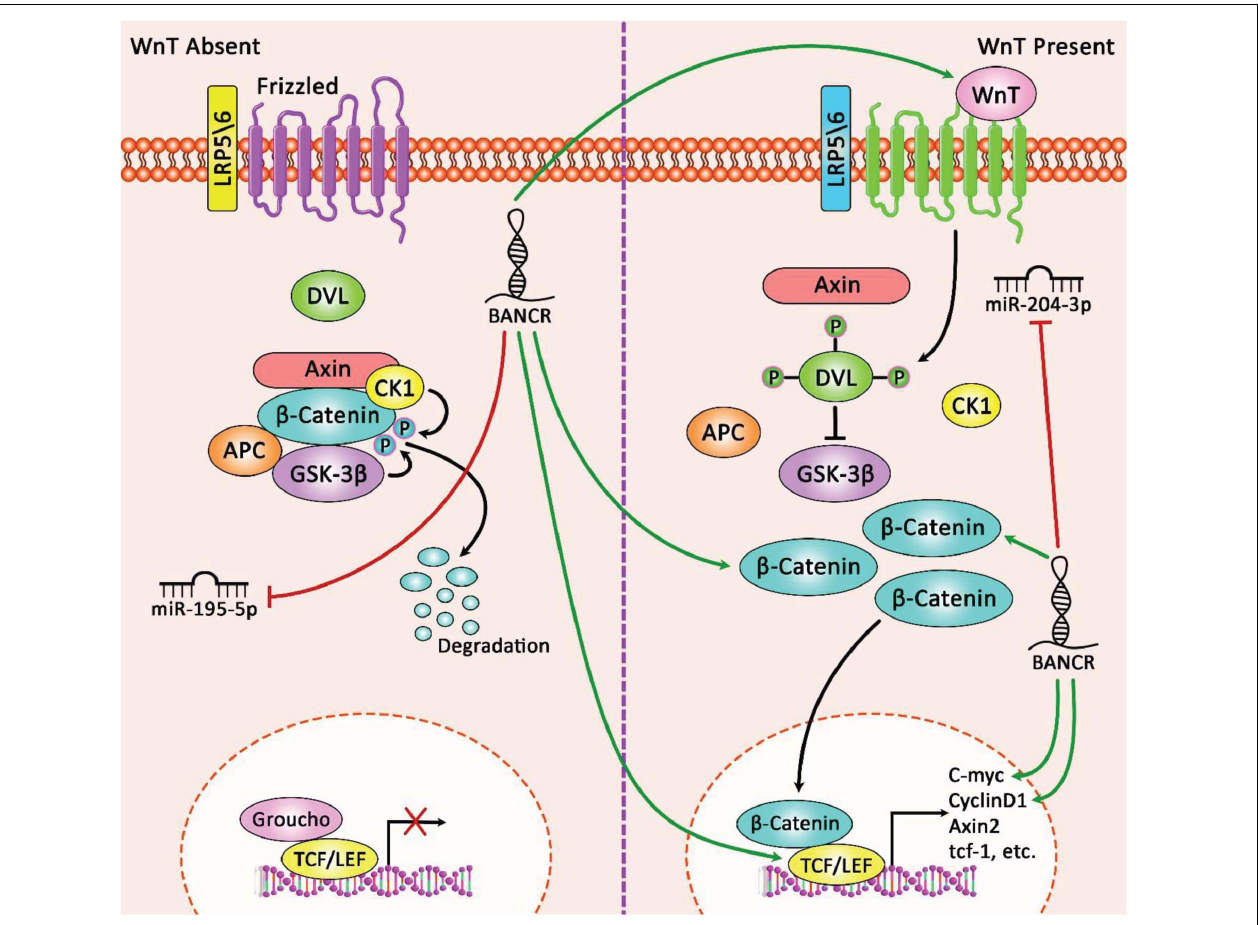
FIGURE 1 | A schematic diagram of the oncogenic role of lncRNA BANCR in regulating Wnt/ β -catenin signaling pathway in pancreatic cancer and retinoblastoma. Accumulating research has figured out that lncRNA BANCR could play a crucial role in triggering the activation of Wnt/ β -catenin cascade in several tumor cells through sponging various miRNAs. As an illustration, this lncRNA could elevate pancreatic cancer tumorigenesis through up-regulating expression levels of β -catenin, c-Myc, and cyclinD1 by miR-195-5p/Wnt/ β -catenin axis in target cells (Wu et al., 2019). In addition, overexpression of lncRNA BANCR through regulating Wnt/ β -catenin pathway could promote cell proliferation, apoptosis, invasion, and migration in retinoblastoma. In fact, this lncRNA via sponging miR-204-3p could have an effective part in enhancing the expression levels of Wnt4, β -catenin, and TCF4 in tumor cells (Sun et al., 2020). Green arrows indicate the up-regulation of target genes modulated via lncRNA BANCR and red arrows depict inhibition of miRNAs regulated by this lncRNA.